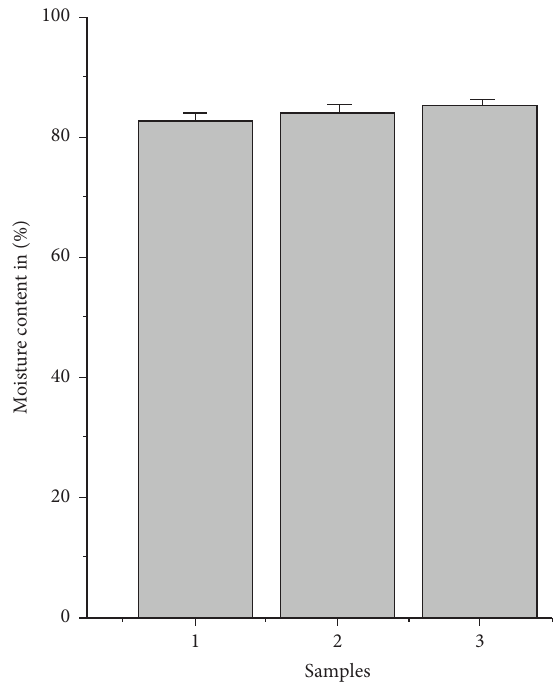
Figure 9: Moisture content of DFS scafold. Te moisture content of DFS scafold was found to be 81.7 ± 3.6%. Te graph is presented as the amount of moisture in % present per identical sample ( N � 3). Te result is expressed as grams of water in 100 g of dry sample weight. Error bars are the standard deviation from triplicate measurements.